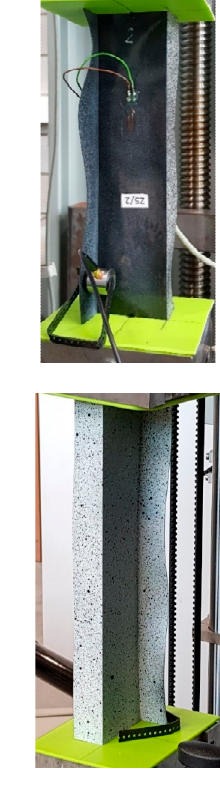
Figure 14. Column z_4—maps of the Tsai–Wu critical parameter and forms of post-critical deformation: ( a ) Test 1 and ( b ) Test 3.